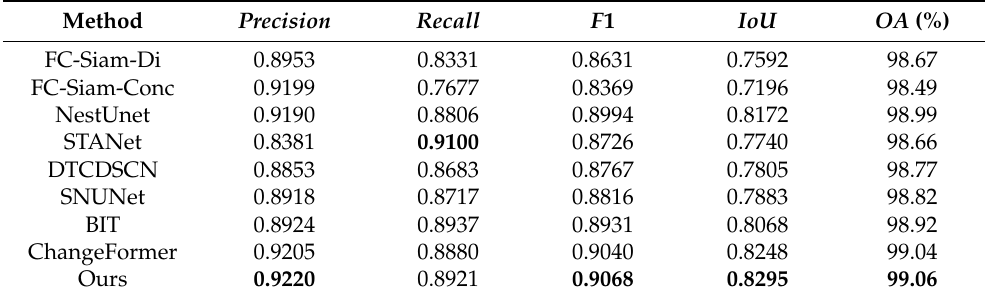
Table 1. Quantitative performance comparison on the LEVIR-CD dataset. (The best performance is emphasized in bold.).